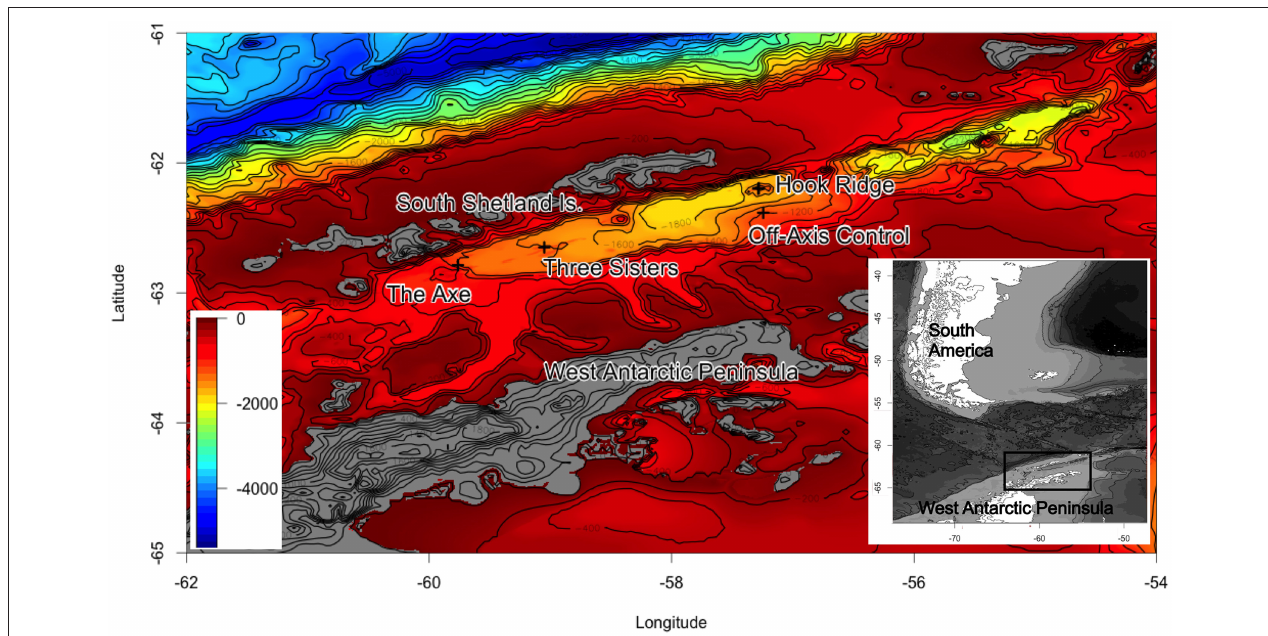
FIGURE 1 | Bathymetric charts of the Bransfield Strait (30 arc-s grids constructed using GEBCO bathymetry) showing sampling locations during JC055. Latitude and longitude given as degrees and decimal